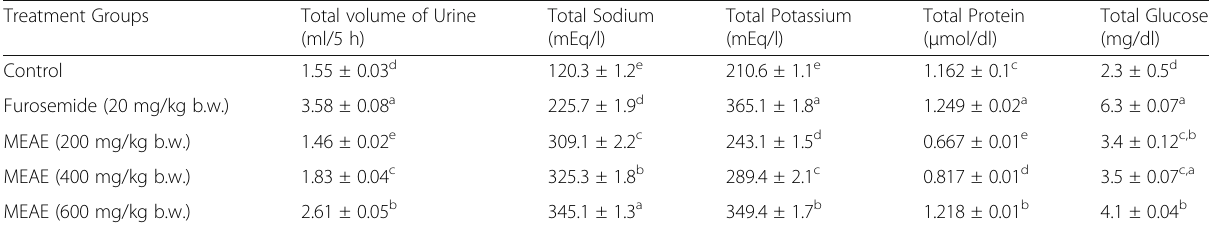
Table 1 Effect of MEAE on diuretic excretion parameters of albino Wistar rat urine